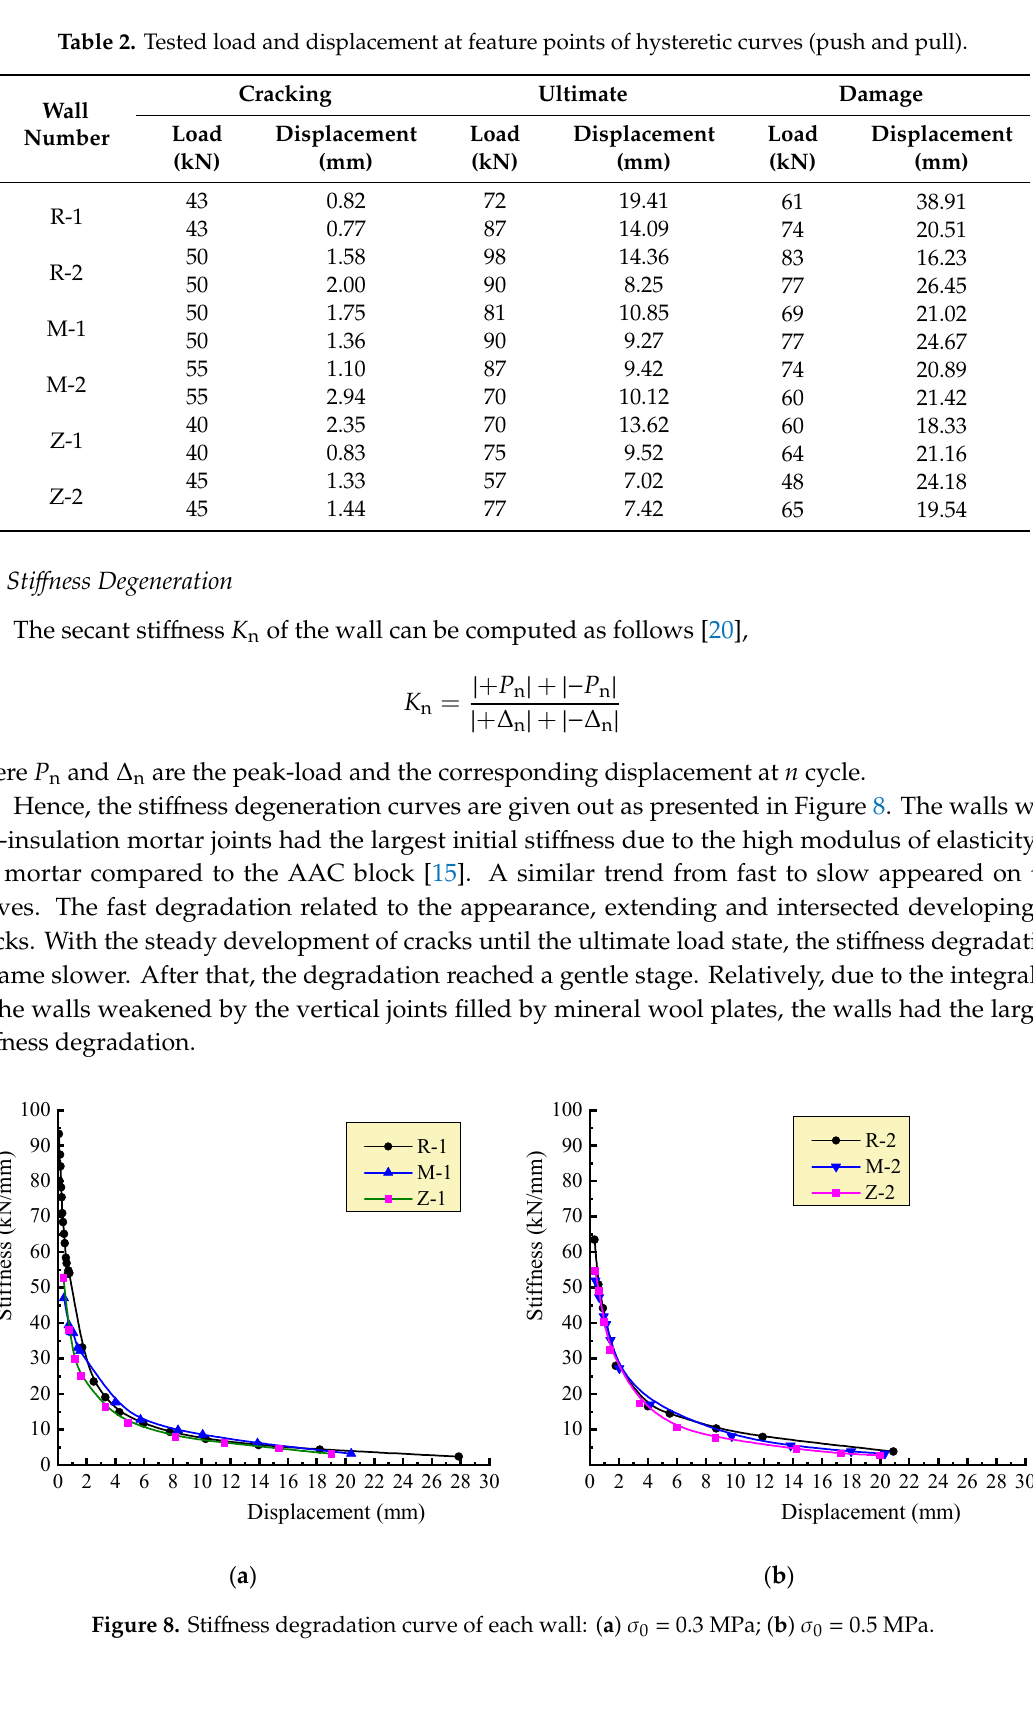
Figure 8. Stiffness degradation curve of each wall: ( a ) σ 0 = 0.3 MPa; ( b ) σ 0 = 0.5 MPa. Figure 8. Sti ff ness degradation curve of each wall: ( a ) σ